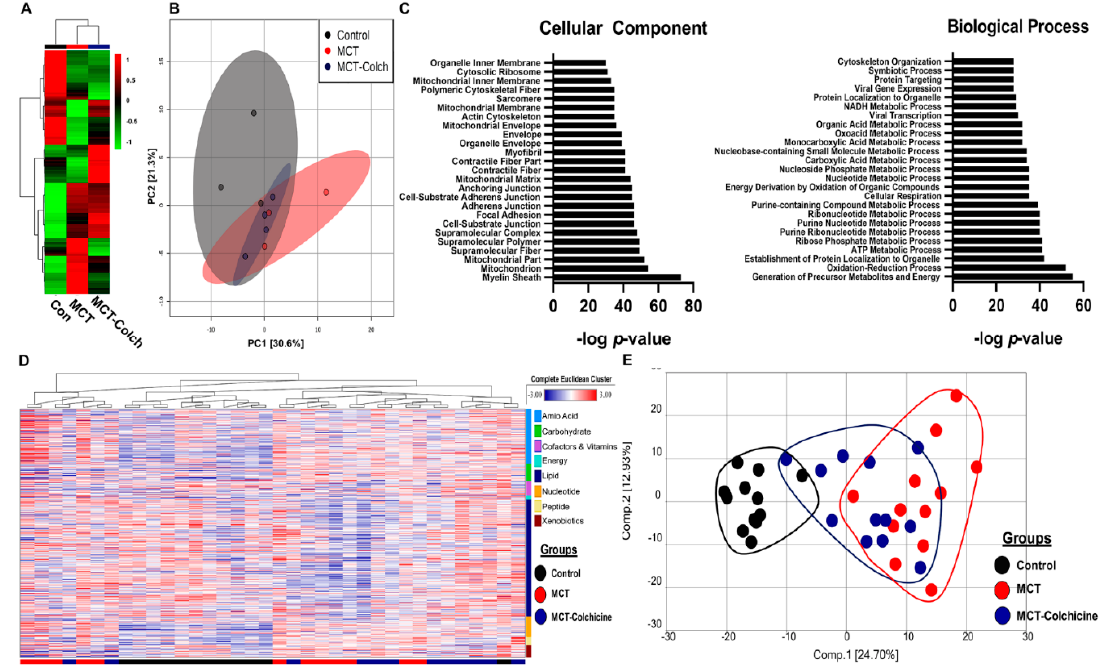
Figure 3. Proteomics and metabolomics link excess O-GlcNAcylation to metabolic dysregulation in the right ventricle. ( A ) Unbiased hierarchical cluster analysis of O-GlcNAcylated immunoprecipitation proteomics experiment. ( B ) PCA plot revealed differences in O-GlcNAcylation signatures in control, MCT, and MCT-Colch right ventricles. ( C ) Gene ontology assessment of cellular component and biological process of O-GlcNAcylated proteins from mass spectrometry experiment. ( D ) Hierarchical cluster analysis of metabolites from right ventricular extracts. Bars at bottom of graph indicate group. Black: control, Red: MCT, and Blue: MCT-Colchicine. On right side of graph, metabolites are clustered based on their classification. ( E ) PCA plot of total metabolomic data reveals MCT-Colch rats display a metabolic signature that is an intermediate of control and MCT. Tissue was harvested 4 weeks after MCT injection. Table 1. Summary of top 10 mitochondrial proteins identified in proteomics experiment.